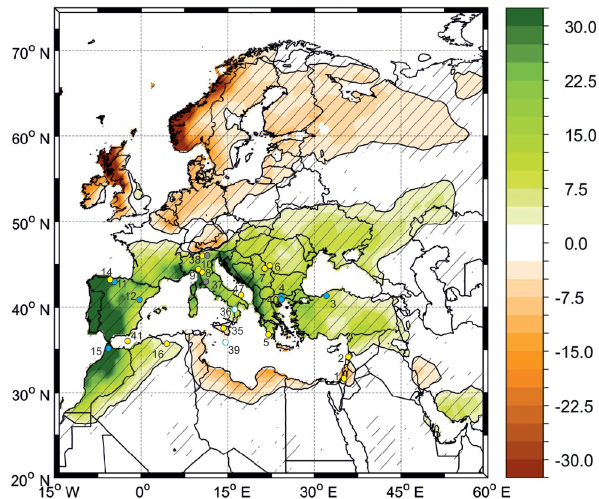
Figure 10. Correlation between the December–January–February NAO index (modified after Per¸soiu et al. (2018)) and precipita- tion amount during negative NAO conditions. A negative corre- lation (brown) indicates that during negative conditions precipi- tation amounts are lower than usual, while a positive correlation (green) indicates that, during negative NAO conditions, precipita- tion is above average. Yellow circles: records indicating drier con- ditions during winter; blue circles: records indicating wetter condi- tions during winter (see Fig.